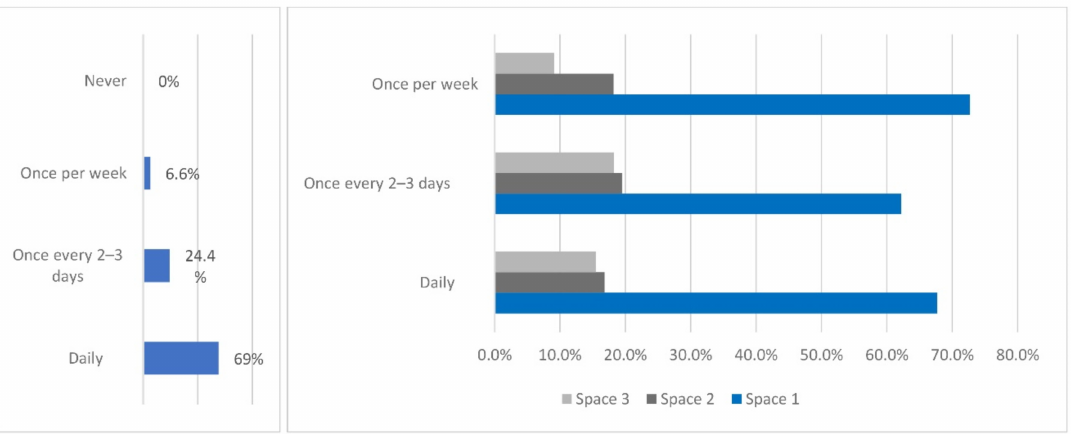
Figure 13. Respondents’ opinions about the routine use of open